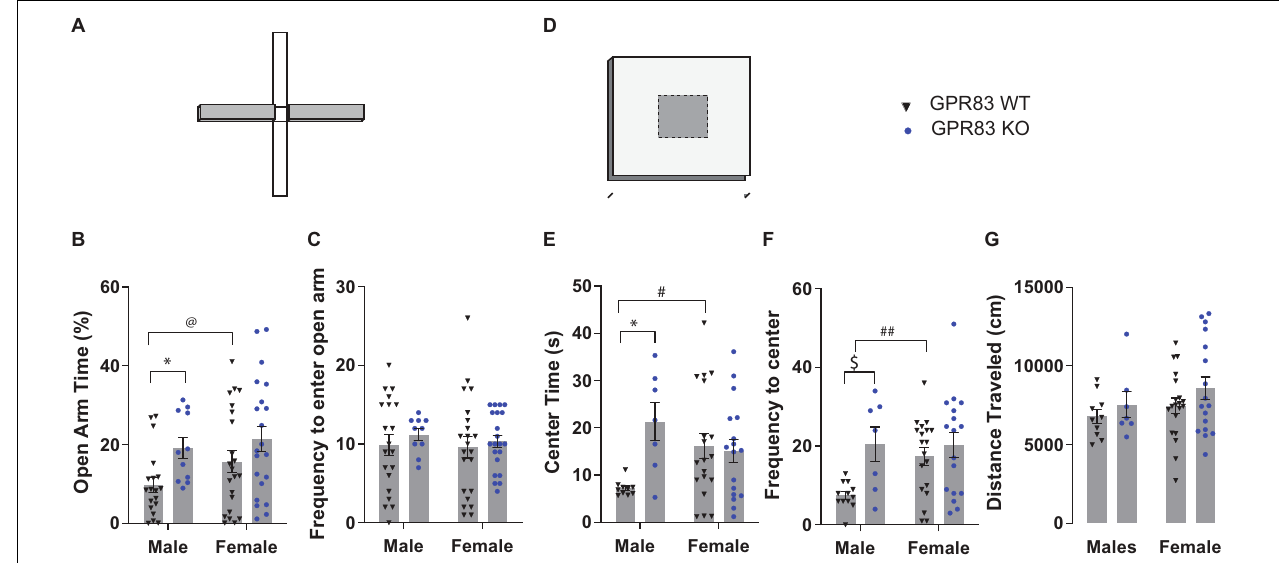
FIGURE 2 | Sex-differences in GPR83-mediated regulation of anxiety-related behaviors. Sex-dependent analysis of WT and GPR83 KO mice on the elevated plus maze (A) measuring open arm time (B) , and frequency to enter the open arm (C) . Sex-dependent analysis of WT and GPR83 KO mice in the open field assay (D) measuring center time (E) , frequency to enter the center (F) , and distance traveled (G) . Data are represented as mean ± SEM and analyzed using two-way ANOVA following Tukey’s post hoc test (* p < 0.05) and unpaired t -test ( $ p = 0.07), % = open arm time/(open arm + closed arm time), @ p = 0.0872; # p < 0.05, ## p < 0.01; WT males, n = 19, GPR83 KO males, n = 11; WT females, n = 22, GPR83 KO females, n = 21.